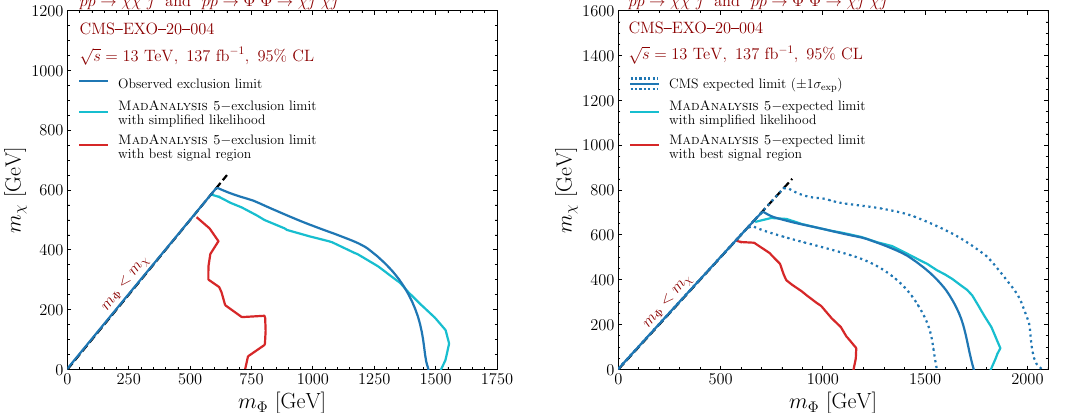
Figure 9: 95% CL exclusion contours as in figure 5, but for a t -channel dark matter simplified model ( pp → ΦΦ → χ j χ j and pp → χχ j ) in the ( m Φ , m derived from the CMS-EXO-20-004